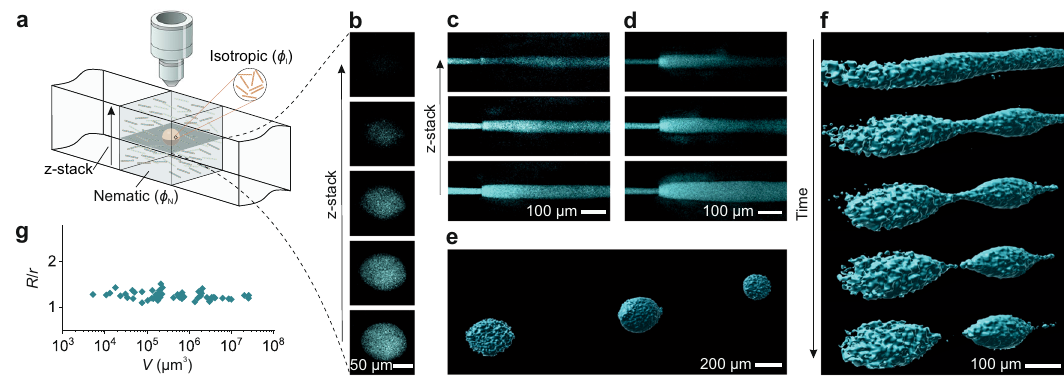
Fig. 3 | Negative tactoids formation by extruding the Onsager branches. a Schematic of an isotropic droplet, that is set at one thermodynamic Onsager branch ϕ I , within a nematic phase set at the other Onsager branch ϕ N , in the micro fl uidicsystem,wherethe fi brilsintheisotropicphasehavebeen fl uorescently dyed with Thio fl avin T. b Confocal images of a single isotropic droplet in different z-stacks, showing the visibility of the tactoid at different heights. c , d Confocal imagesofisotropicjetwithdifferentdiametersclosetothetipoftheinnercapillary